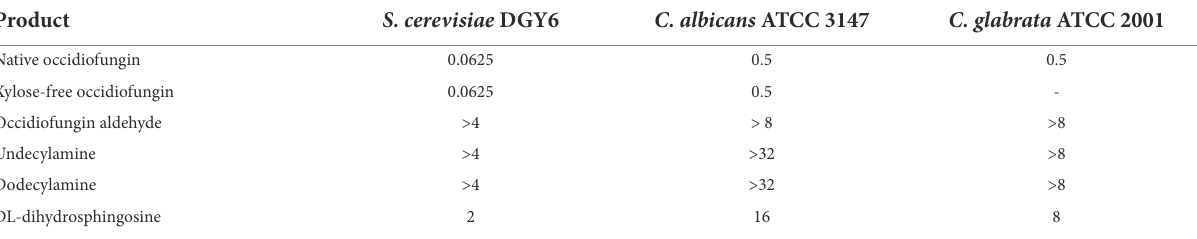
TABLE 3 MIC ( μ g/ml) of occidiofungin analogs against Saccharomyces cerevisiae DGY6 haploid BY4741, Candida albicans ATCC 3147, and Candida glabrata ATCC 2001.